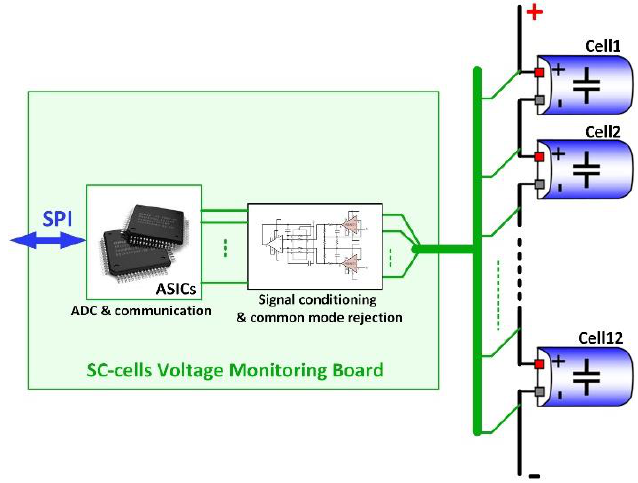
Figure 3. Block diagram representing cells ’ voltage monitoring within a single SC module as a part of the full voltage monitoring subsystem of the SC-ESS.